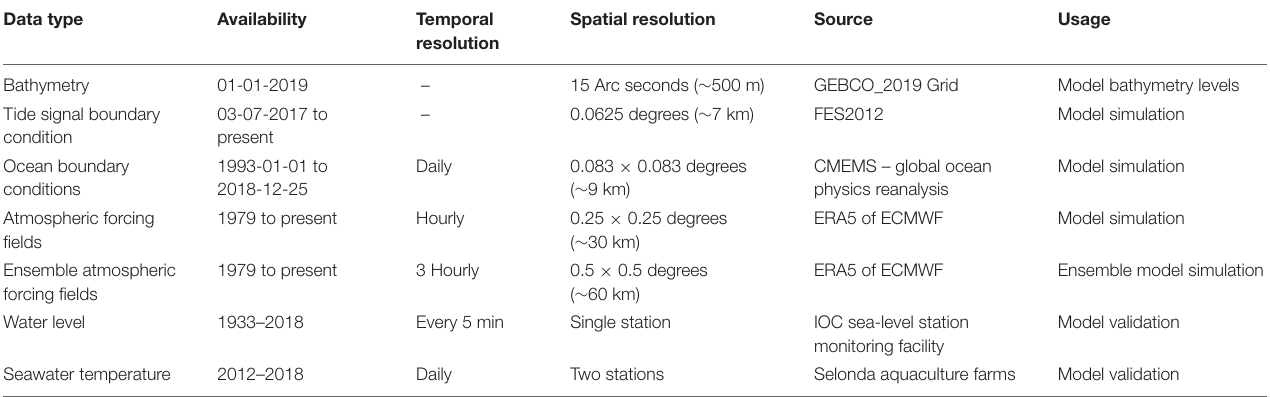
TABLE 1 | List of data used in the study.